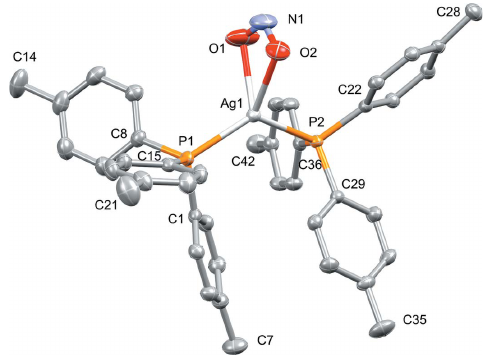
Figure 1 Perspective view of the molecular structure of the title compound showing displacement ellipsoids at the 50% probability level. Hydrogen atoms are omitted for